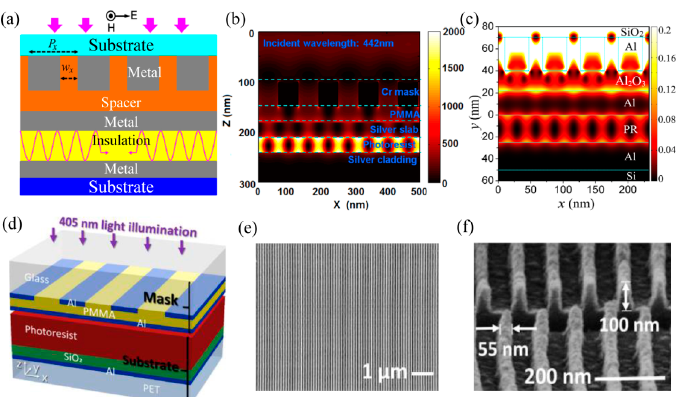
Figure 9. ( a ) Schematic structure of the odd SPP mode interference lithography; Simulation results at the wavelength of ( b ) 442 nm and ( c ) 193 nm; ( d ) Experimental structure for the odd SPP mode interference lithography; ( e ) Top view and ( f ) Cross section of SEM pictures of 100 nm-thick photoresist. Reproduced from: (b), [55], Copyright © 2009, Springer; (a,c), [56], Copyright © 2014, NPG; (d–f), [57], Copyright © 2016, ACS.